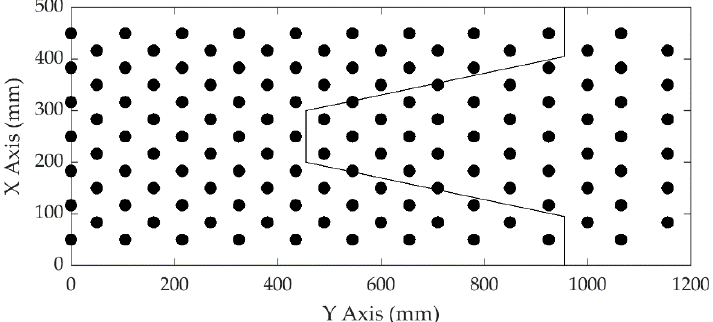
Figure 2. Example of grid of measurement points at which the water depth was measured.